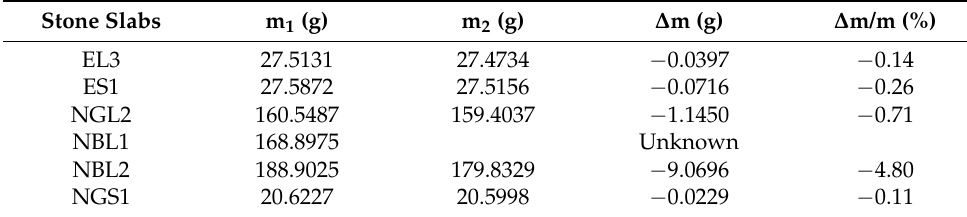
Table A2. Changes in terms of mass of the selected stone slabs. Stone Slabs